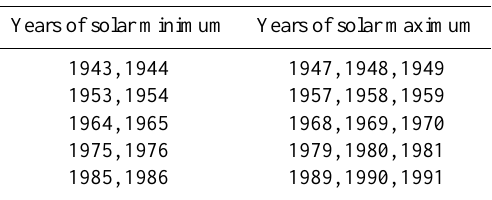
Table 1. Years of solar minimum and maximum used in the analysis Years of solar minimum Years of solar